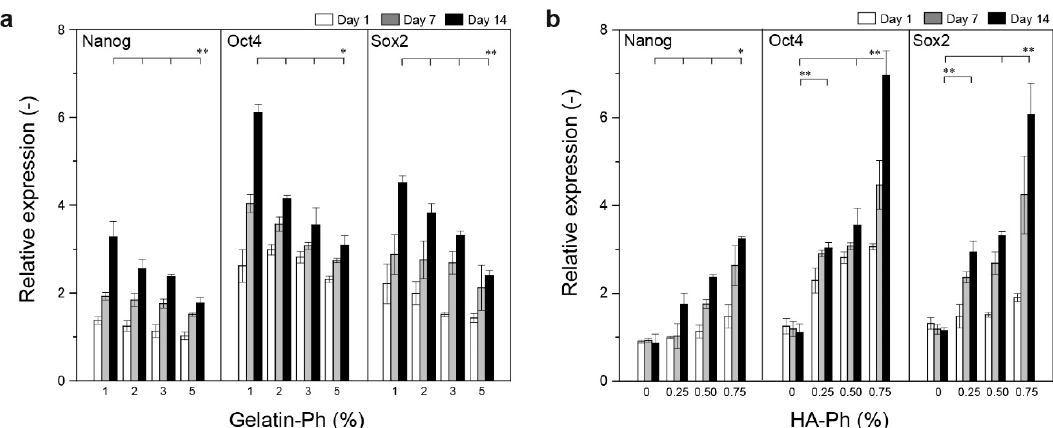
Figure 8. Effects of gelatin-Ph and HA-Ph content on the expression of stem cell marker genes, Nanog , Oct4 , and Sox2 . Cell-laden hydrogels were prepared by varying ( a ) gelatin-Ph content at 0.5% HA-Ph, and ( b ) HA-Ph content at 3.0% gelatin-Ph. Bars: S.D. ( n = 3). The relative expressions were calculated with the cells obtained before enclosing hydrogels as the reference. * p < 0.05, ** p < 0.01.